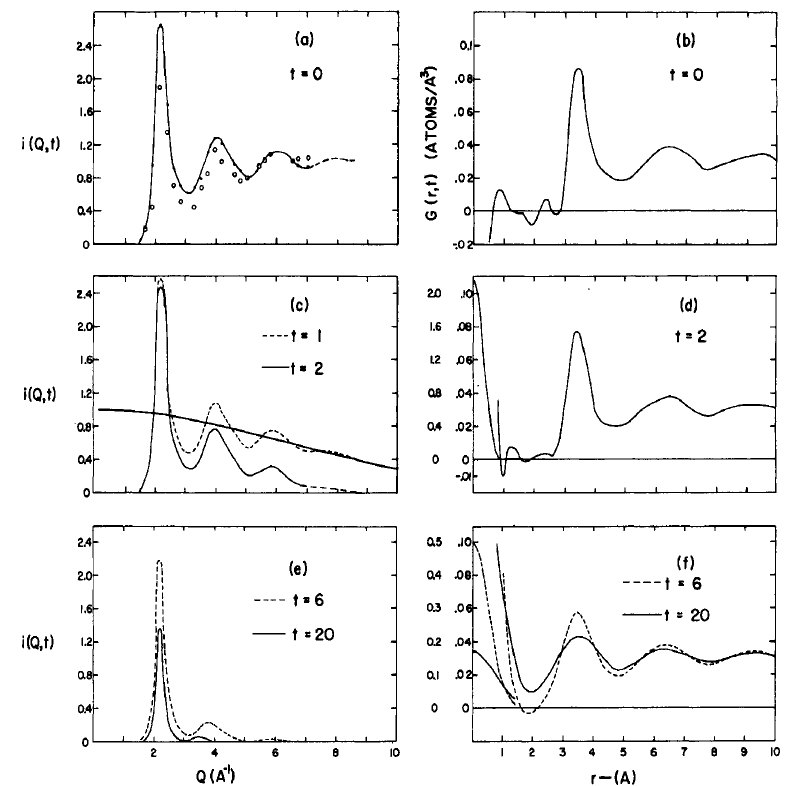
Figure 38. A selection of smoothed curves for liquid lead of I(Q, t) plotted against Q, boxes ( a – c ), and also G(r,t) boxes ( d – f ) against r for values of time t of 0, 0.1, 0.2, 0.6, and 2 × 10 − 12 s. The closed circles in Figure ( a ) show the experimental points for the integrated intensities I(Q,0) = S(Q). The open circles are values of I(Q,0) calculated from the second moment of the energy distribution. The left hand scales in boxes ( b ) ( d ) and ( f ) apply to G(0,t). This figure is taken from Figure 2 of ref. [96]. Copyright by the American Physical Society.